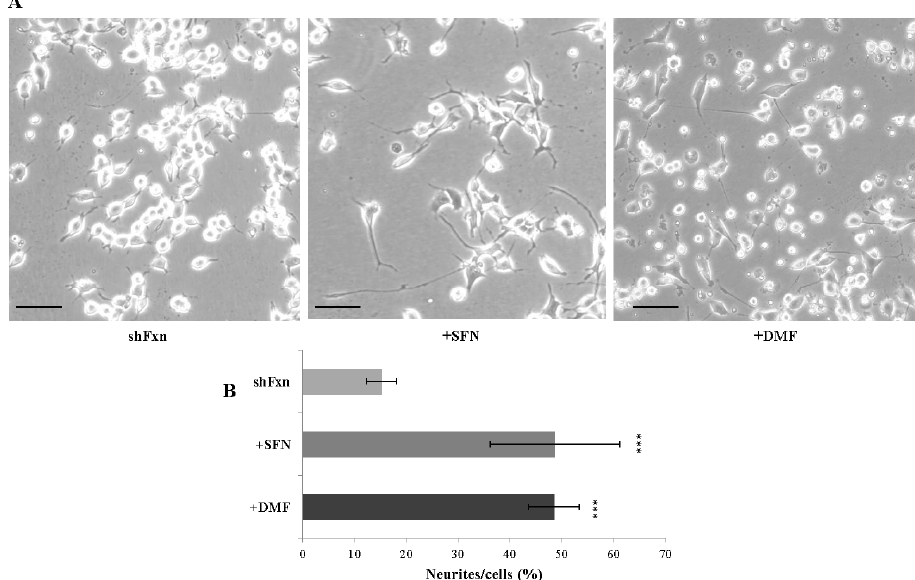
Figure 4. Nrf2-inducers trigger axonal re-growth in the shFxn. ( A ) Bright field photographs of untreated shFxn, 5 µM (24 h) SFN and 30 µM (24 h) DMF treated cells. A re-organization of the neurites network is evident; ( B ) The number of neurites has been measured by ImageJ software and normalized for number of cells (*** p <0.001; bar = 100 µm).